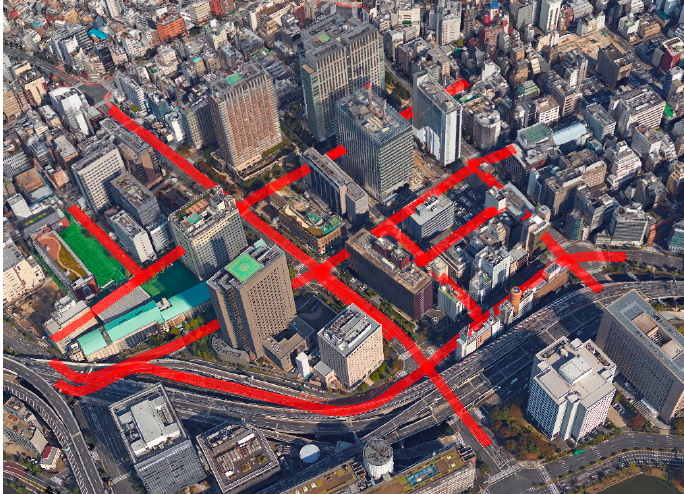
Figure 19. The experimental area around Hitotsubashi intersection, a dense urban area in Chiyoda-ku, Tokyo, Japan.